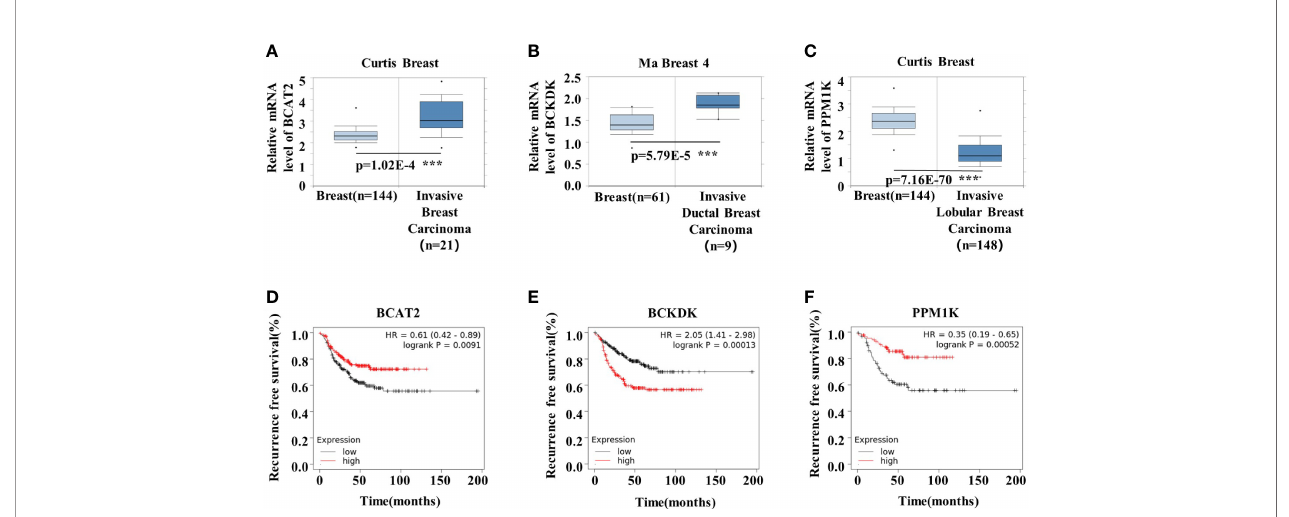
FIGURE 1 | BCAA metabolic remodeling is strongly associated with breast cancer prognosis. (A-C) mRNA expression levels of BCAA catabolic enzymes were analyzed by Oncomine database: (A) BCAT2 , (B) BCKDK , (C) PPM1K . (D) Kaplan-Meier RFS curves strati fi ed by BCAT 2 expression levels in 392 TNBC patients. The mean BCAT2 mRNA value was used to assign patients to two subgroups (ID203576 at). (E) Kaplan-Meier RFS curves strati fi ed by BCKDK expression levels in 392 TNBC patients. The mean BCKDK mRNA value was used to assign patients to two subgroups (ID202030 at). (F) Kaplan-Meier RFS curves strati fi ed by PPM1K expression levels in 176 TNBC patients. The mean PPM1K mRNA value was used to assign patients to two subgroups (ID244011 at). Mean ± SD, ***p < 0.001, Student ’ s